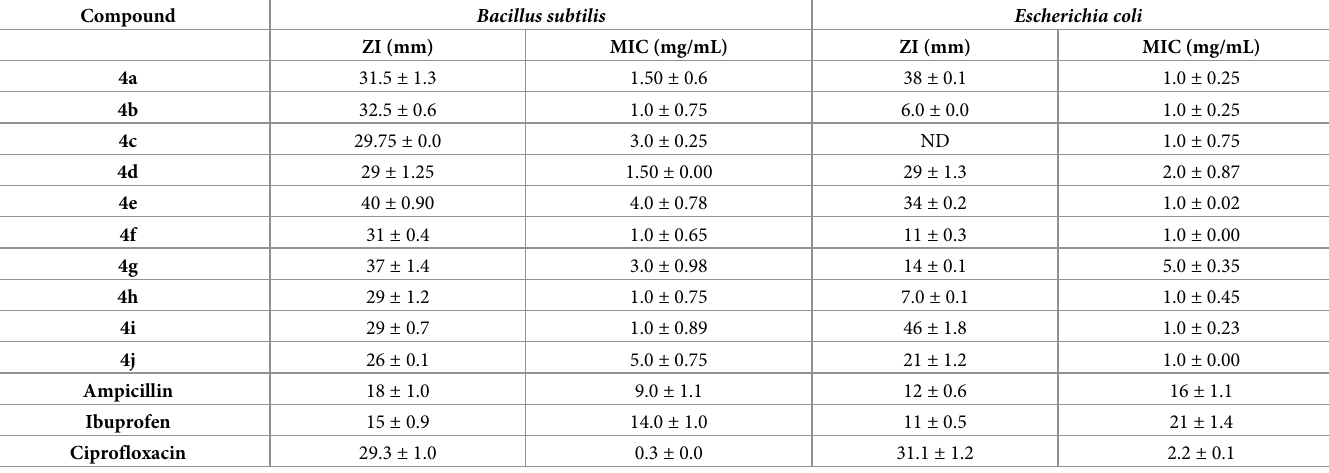
Table 2. Zone of inhibition values (millimeters) of compounds 4a-j.